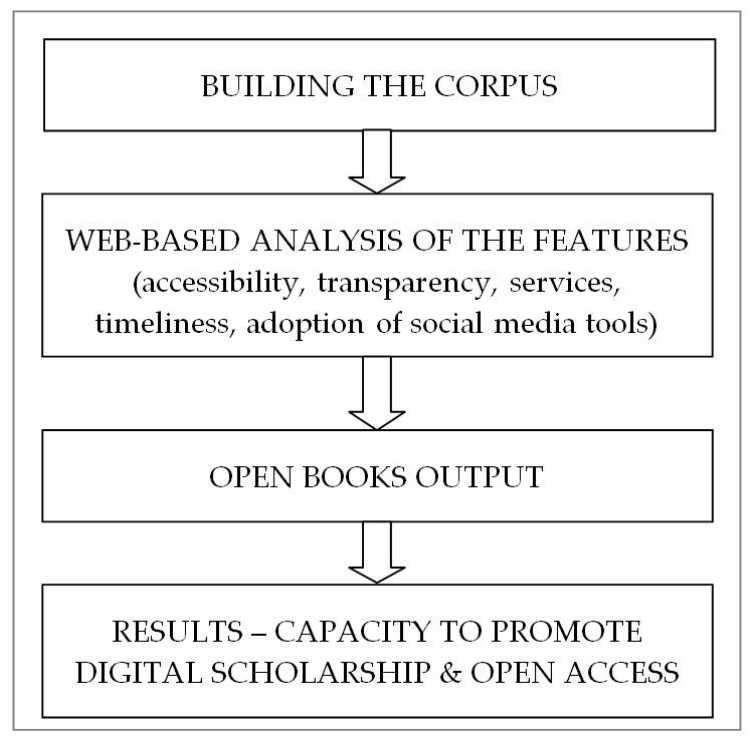
Figure 1. Quantitative research design.